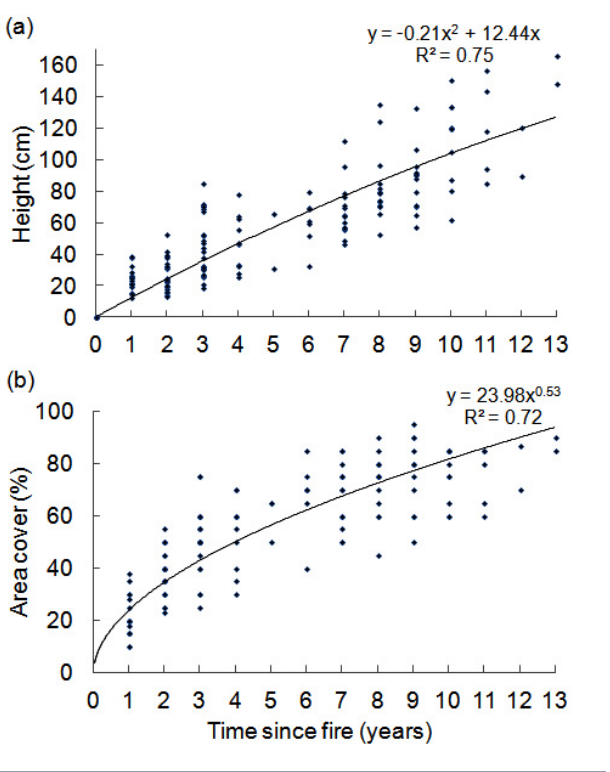
Fig. 10 . (a) Height of Erica trimera in relation to time since fire. (b) Canopy cover of Erica spp. (both E. trimera and E. arborea ) in relation to time since